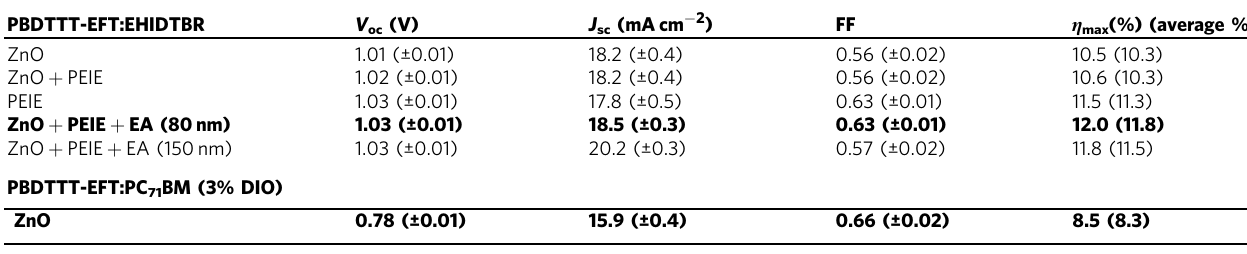
Table 1 Key photovoltaic parameters of PBDTTT-EFT:PC 71 BM and PBDTTT-EFT:EHIDTBR solar cell devices using different modi fi ed electron-transport layers PBDTTT-EFT:EHIDTBR